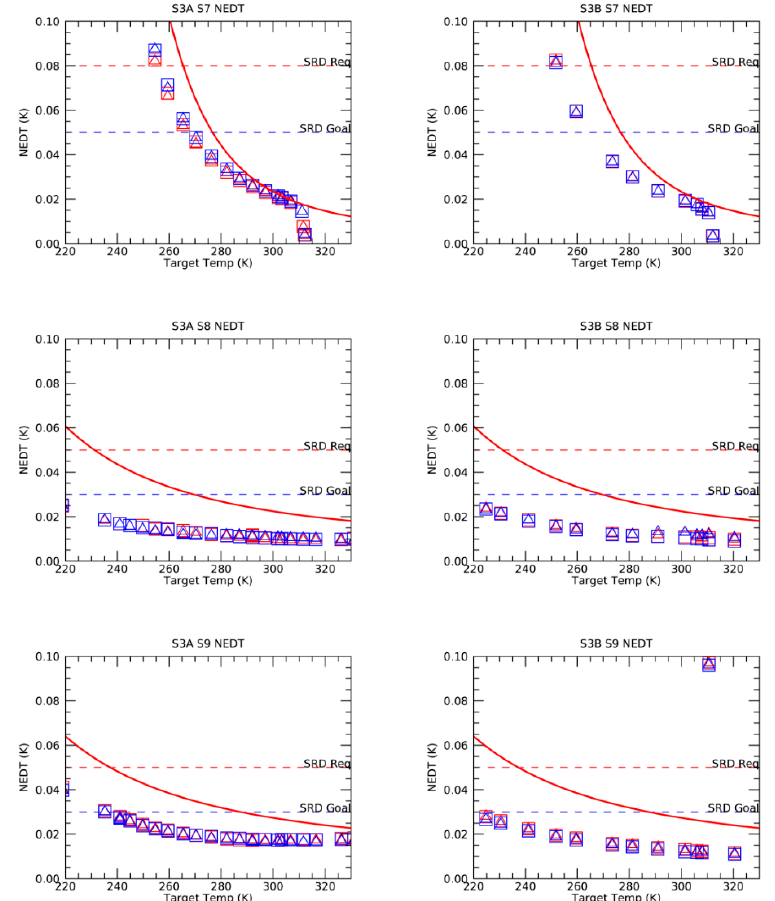
Figure 4. SLSTR-A and B NEDT measured during pre-launch calibration tests, from [12]. The solid line is the predicted end-of-life estimate derived from the instrument model [11]. ☐ = Detector 1, Integrator 1; ☐ = Detector 1, Integrator 2; Δ = Detector 2, Integrator 1; Δ = Detector 2, Integrator 2.